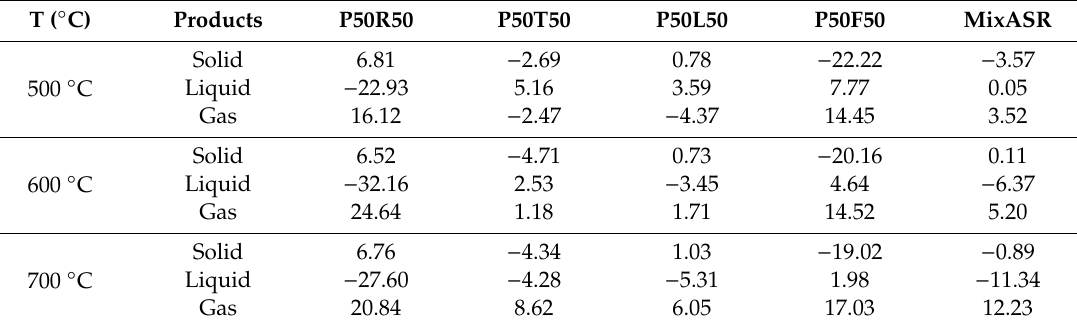
Table 5. The di ff erences between the experimental results and the calculated results. T ( ◦